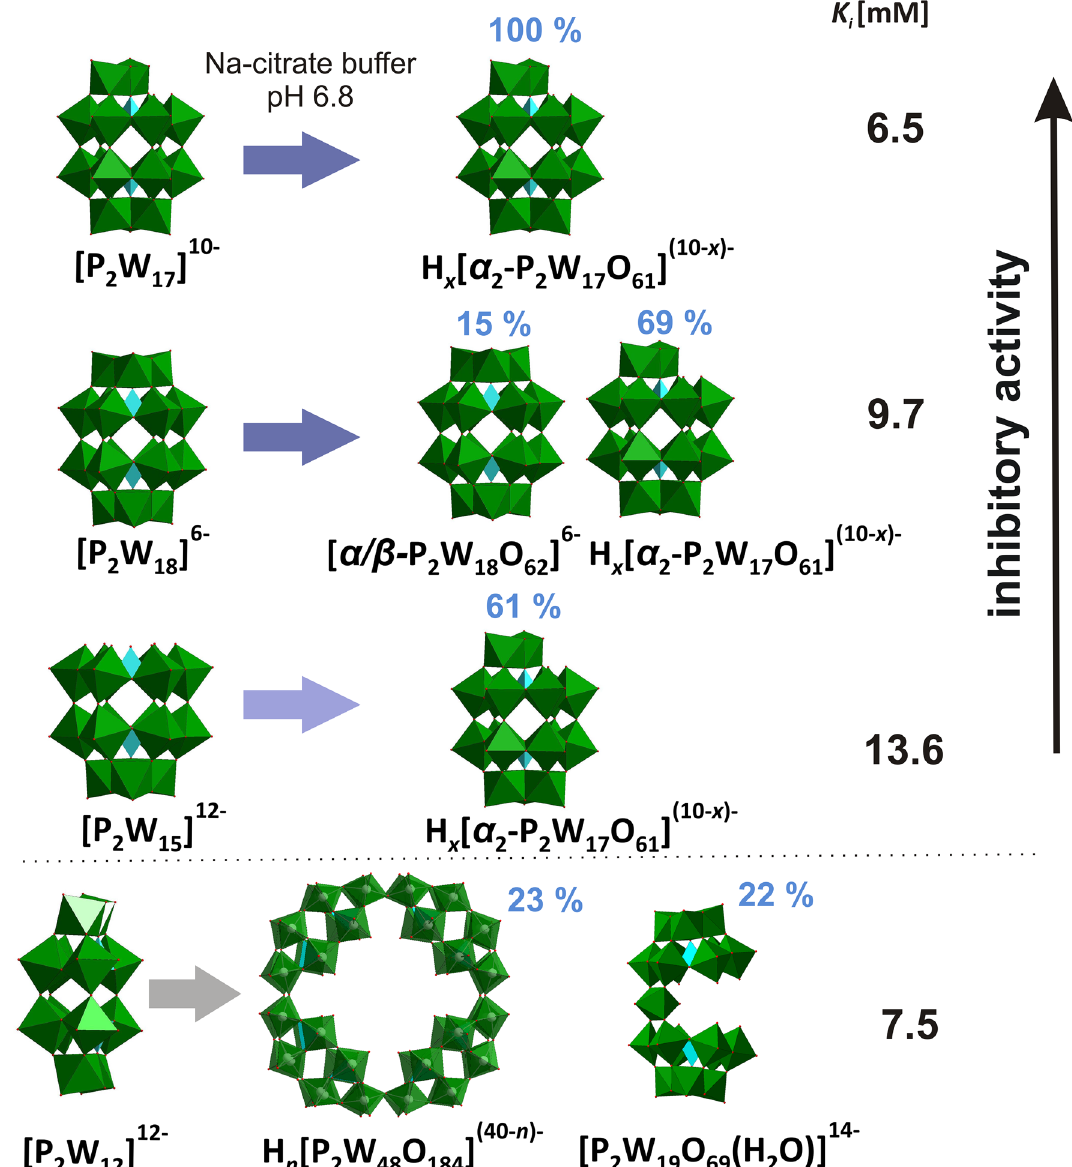
Figure 4. The POTs’ inhibitory activities are compared with the main species at pH 6.8 and at assay conditions. The intensity of the blue arrows correlates with the relative rearrangement to H x [ α 2 -P V 2 W VI 17 O 61 ] (10− x )− ( x = 3 or 4) for the different inhibitors at pH 6.8. The more H x [ α 2 -P V 2 W VI 17 O 61 ] (10− x )− ( x = 3 or 4) is in the sample, the higher the observed inhibitory activity of the POT. For [ P 2 W 12 ] 12− two predominant species are shown. n = 7–16 in H n [P V 8 W VI 48 O 184 ] (40−n)- according to 58 . Color code : {WO 6 } octahedra, green; {PO 4 } tetrahedra, S11, Table S2) were observed for the other three POT samples [ P 2 W 17 ] 10− , [ P 2 W 15 ] 12− and [ P 2 W 12 ] 12− , it can be concluded that only the intact [P V 2 W VI 18 O 62 ] 6− accepts electrons in the presence of L -DOPA. This reduction and protonation from [P V reduction might affect inhibitory activity of [ P 2 W 18 ] 6− based on the lower value of R 2 for [ P 2 W 18 ] 6− as compared to the ones observed for the other Wells–Dawson POTs [ P 2 W 17 ] 10− , [ P 2 W 15 ] 12− and [ P 2 W 12 ] 12− (Table 1). Charge density dependence of inhibitory effects of Wells–Dawson POT species. The charge density of POMs, expressed in number of charges ( q ) per addenda metal ions ( m ), is a criterion to character- ize the chaotropic behavior of POMs (Table S6) 49–53 . Recently, it was shown that the affinity of POMs towards biomolecules is attributable to their superchaotropic character, and POMs with moderate charge densities ( q/m = 0.33) interact considerably strong with surfaces of different or mixed polarities, which are present in protein molecules 54 . The activity of [ P 2 W 18 ] 6− , [ P 2 W 17 ] 10− and [ P 2 W 15 ] 12− solutions correlates with the amount of the dominant monolacunary anion [ α